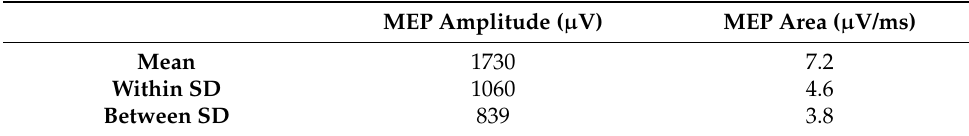
Table 1. Baseline raw motor-evoked potential (MEP) values for absolute MEP amplitude and MEP area.